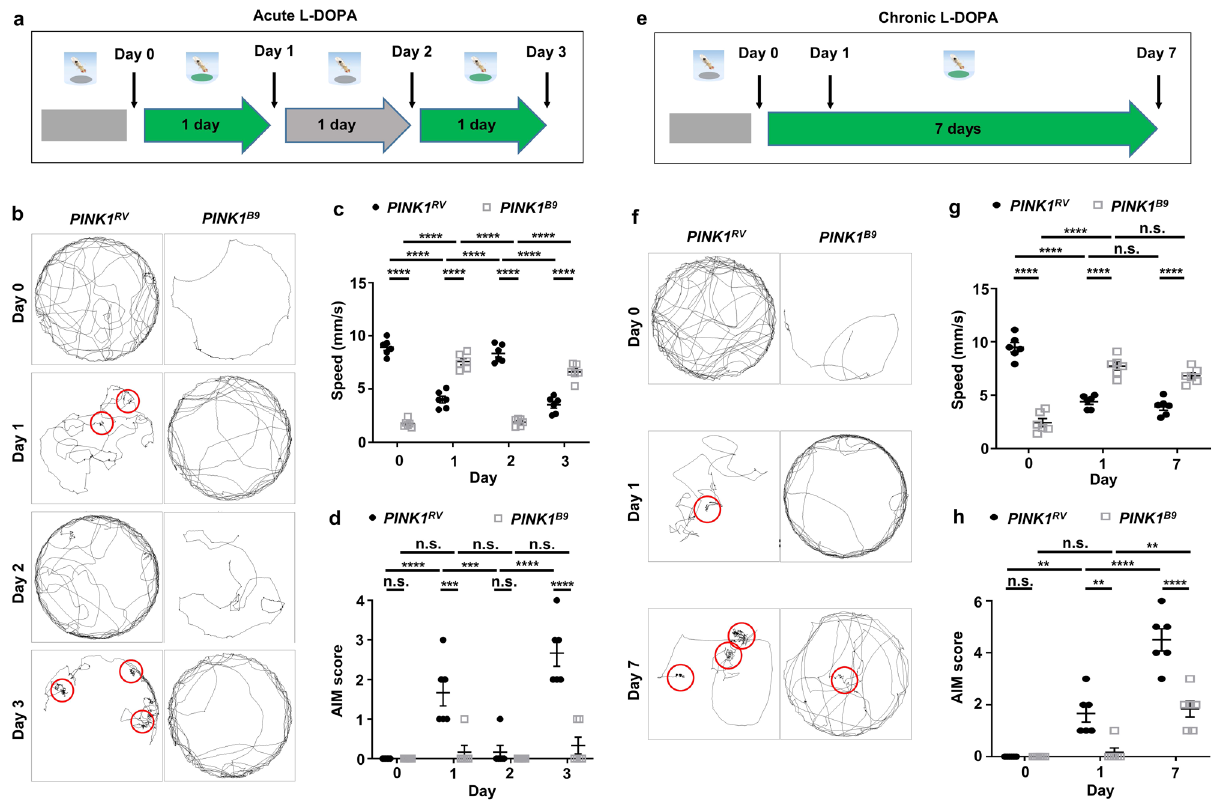
Fig. 3 Acute L-DOPA treatment rescues PD-associated motor defects, but prolonged L-DOPA treatment induces AIMs by PD model fl ies. a Experimental scheme to assay single fl y trajectories upon acute L-DOPA diets intercalated with control diets. Thick green and gray arrows indicate time periods of L-DOPA and control diets, respectively. Black arrows indicate video recordings of the fl y movement. b Representative trajectories of a control ( PINK1 RV ) and a PD model fl y ( PINK1 B9 ) upon acute L-DOPA diets. Abnormal locomotor patterns are highlighted in red circles. c , d Comparisons of the quanti fi ed speed ( c ) and AIM scores ( d ) of the control and PD model fl ies upon acute L-DOPA diets. N = 6. **** p < 0.0001; *** p < 0.001; n.s., not signi fi cant ( p > 0.05) by two-way ANOVA Tukey ’ s multiple comparison test and are presented as means ± SEM. p < 0.05 was considered statistically signi fi cant. e Experimental scheme to assay single fl y trajectories upon chronic L-DOPA diets intercalated with control diets. Thick green and gray arrows indicate time periods of L-DOPA and control diets, respectively. Black arrows indicate video recordings of the fl y movement. f Representative trajectories of a PINK1 RV and a PINK1 B9 fl y upon chronic L-DOPA diet. Abnormal locomotor patterns are highlighted in red circles. g , h Comparisons of the quanti fi ed speed ( g ) and AIM scores ( h ) of the control and PD model fl ies upon chronic L-DOPA diet. N = 6. **** p < 0.0001; ** p < 0.01; n.s., not signi fi cant ( p > 0.05) by two-way ANOVA Tukey ’ s multiple comparison test. Data are presented as means ± SEM. p < 0.05 was considered statistically signi fi